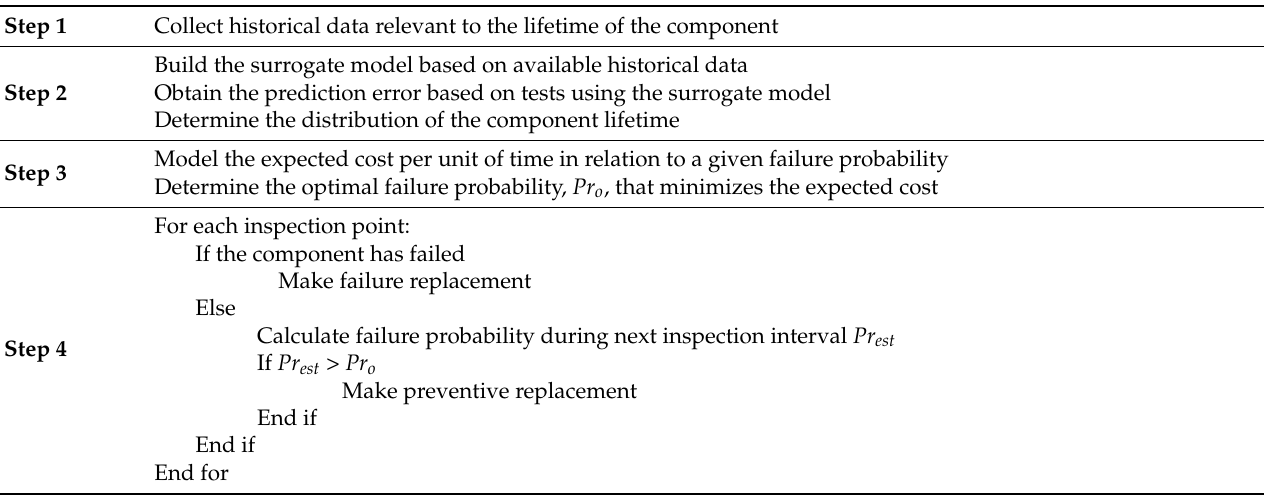
Table 1. Procedure of the proposed CBM